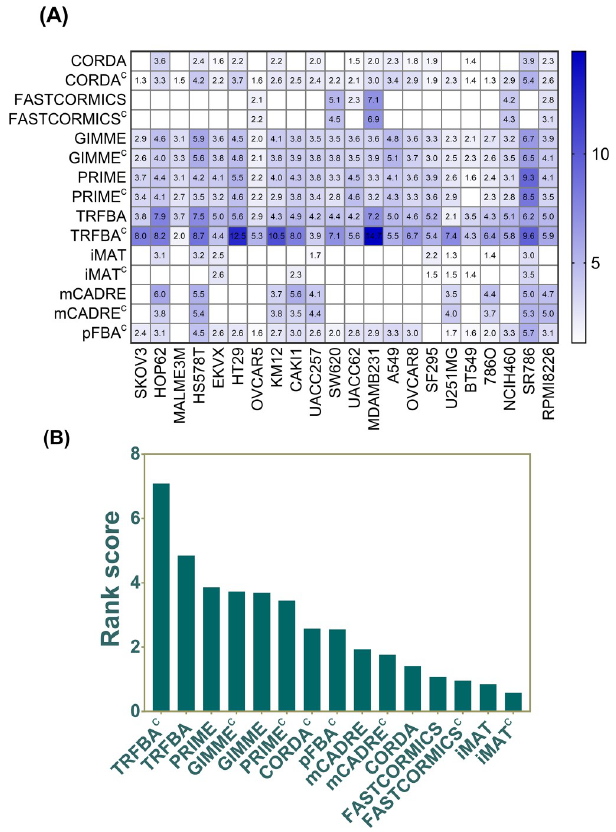
Fig 4. Prediction of general cancer essential genes. (A) Heatmap of enrichment p-values for predicted cell-line specific essential genes. The numbers indicate -log 10 enrichment p-values. GEMs with insignificant p-values are shown in white. (B) Rank scores of the algorithms based on their significance and the number of GEMs with significant enrichment (as described in S2 Text).